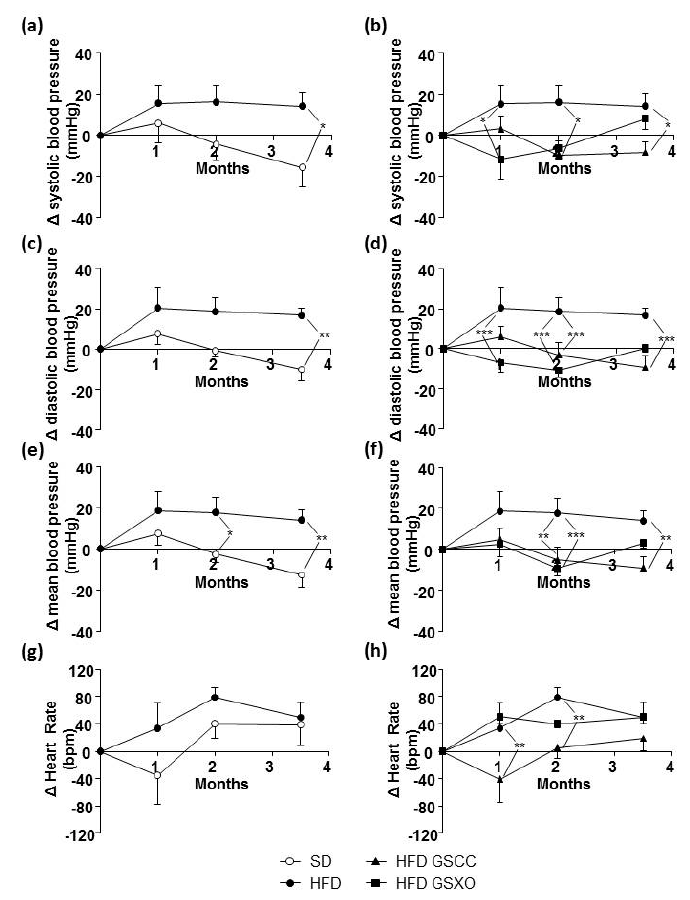
Figure 4. Effect of diet and apple supplementation on hemodynamic parameter of ApoE-/- mice. Systolic ( a , b ), diastolic ( c , d ), mean ( e , f ) pressure, and heart rate ( g , h ) variations in mice receiving standard diet (SD), high fat diet (HFD), and HFD supplemented with apple for 14 weeks. The data were expressed as the mean ± SEM. * p < 0.05, ** p < 0.01, *** p < 0.001.